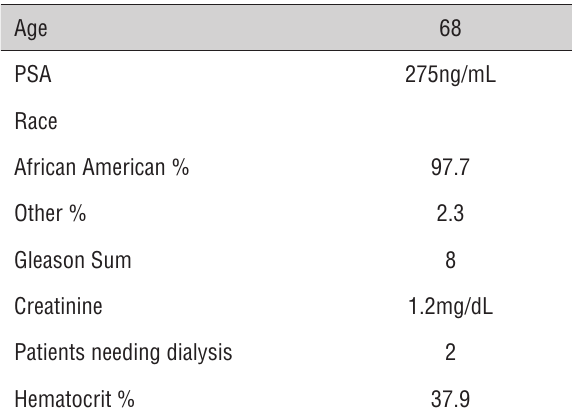
Table 1 - Demographics and presenting laboratory values (median).